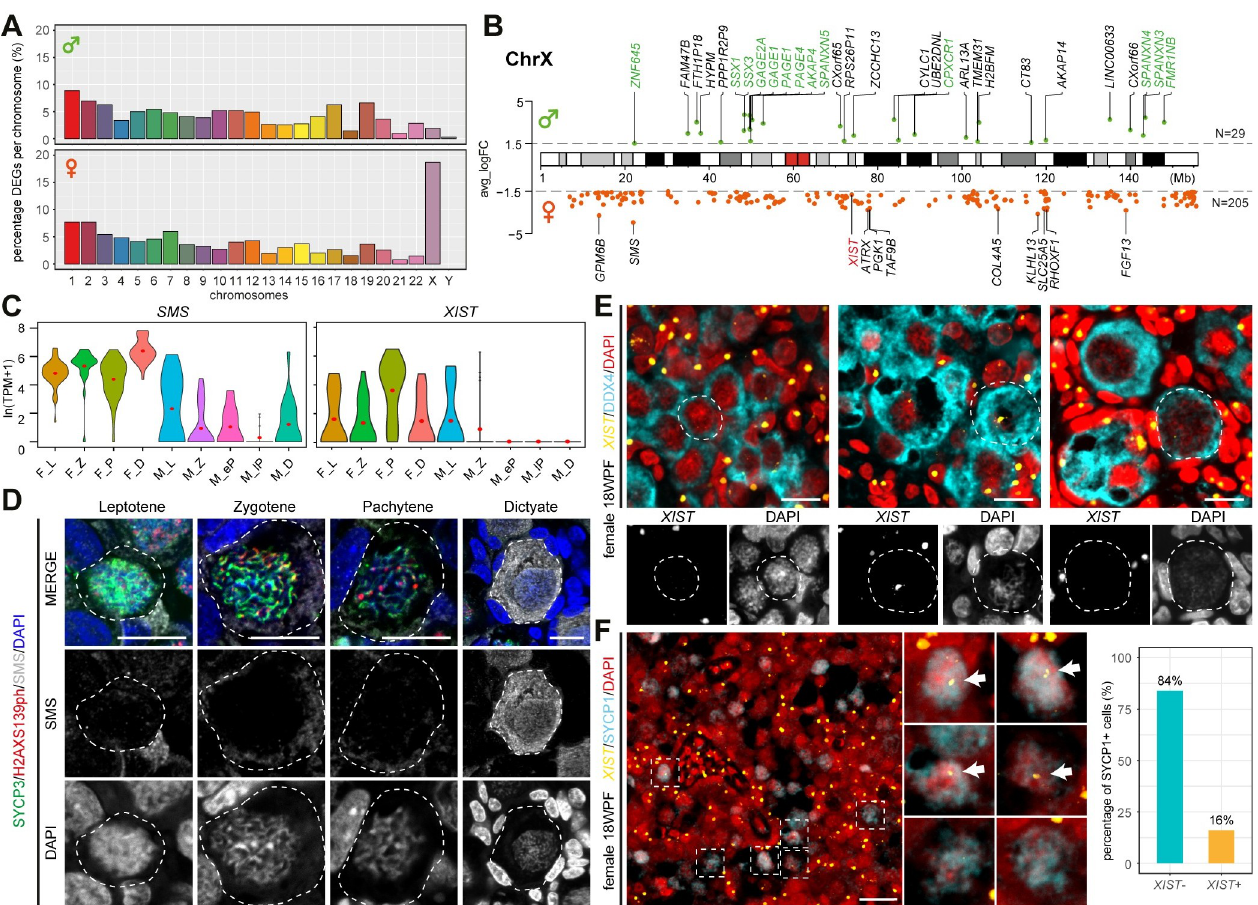
Fig 5. Differences in X-linked expression between the sexes. (A) Bar plot showing the percentage of meiotic male-DEGs (top) and female-DEGs (bottom) per chromosome. (B) Loci map of the X-linked meiotic male-DEGs (top) and female-DEGs (bottom) on the ChrX. Genes in green belong to the family of cancer/testis antigens, XIST is in red. (C) Violin plots showing expression of SMS and XIST . Red dots mark mean expression per cluster (pre-meiotic, pM; leptotene, L; zygotene, Z; pachytene, P and dictyate/diplotene, D). (D) Immunofluorescence for SMS, SYCP3 and H2AXS139ph in leptotene, zygotene, pachytene and dictyate FGC in 14-18WPF ovarian sections. Scale bars are 10 μ m. (E) RNA FISH for XIST combined with immunofluorescence for DDX4 in 18WFP ovaries. White dashed lines indicate selected DDX4+ FGC shown with separate channels for XIST and DAPI (bottom). Scale bars are 10 μ m. (F) RNA FISH for XIST combined with immunofluorescence for SYCP1 in 18WFP ovaries (left) and quantification of SYCP1+ FGC regarding XIST expression (right). White dashed boxes indicate selected SYCP1+ FGC, magnified in the middle panels. White arrows indicate XIST . Scale bars are 20 μ